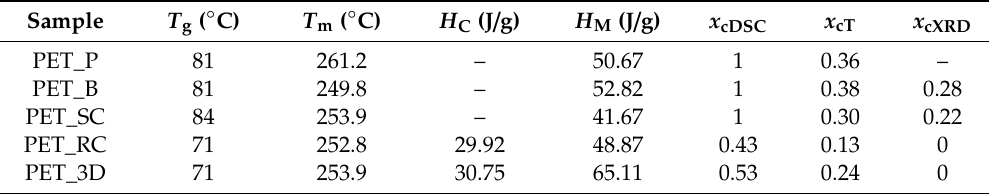
Table 1. Properties of studied PET samples. T g was measured as the inflection point and T m at the endothermic